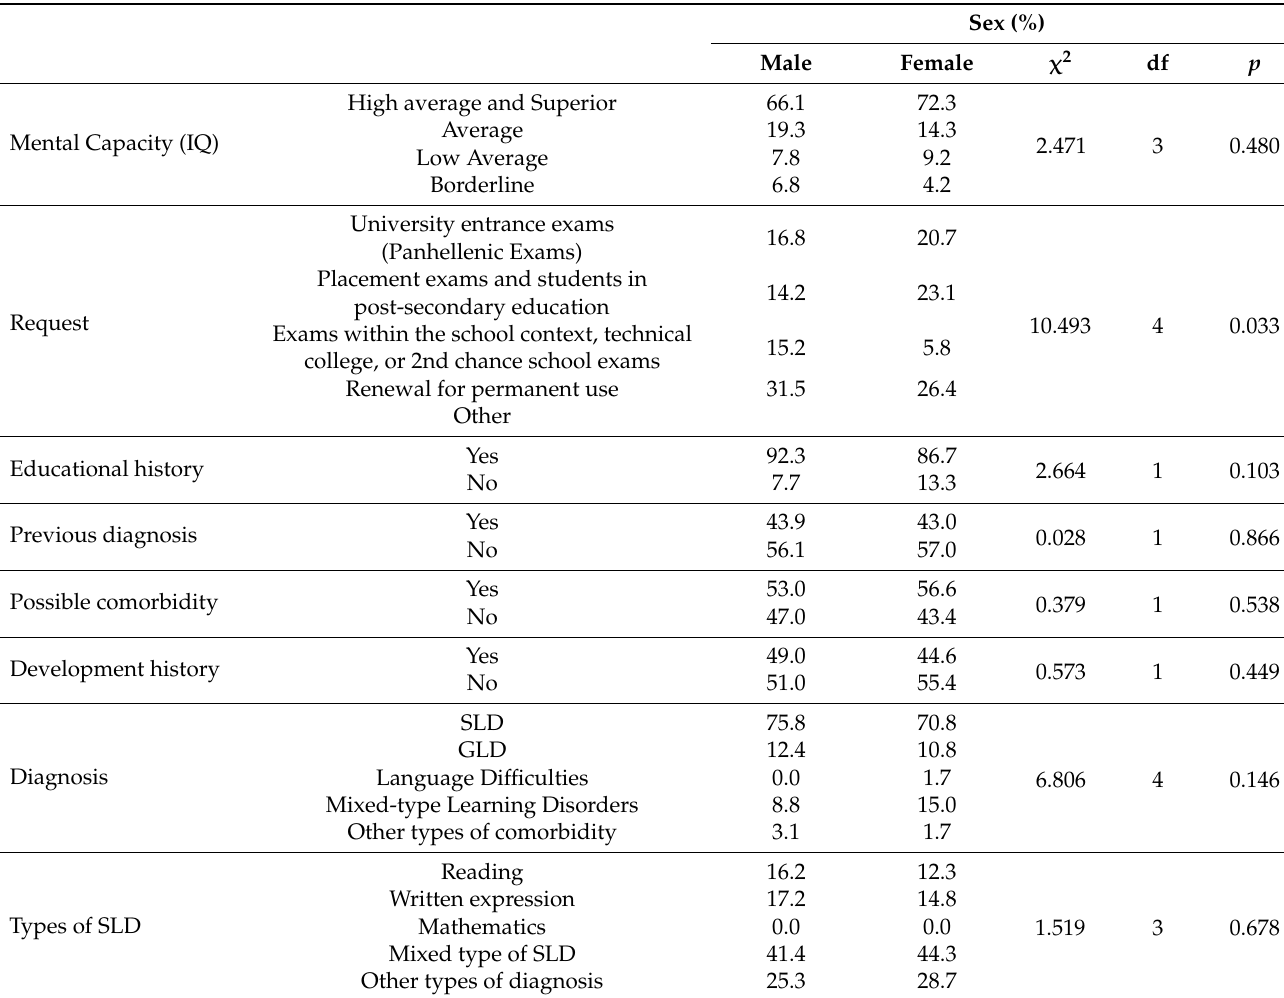
Table A11. Relationship of the Sex of the assessed adults with the other